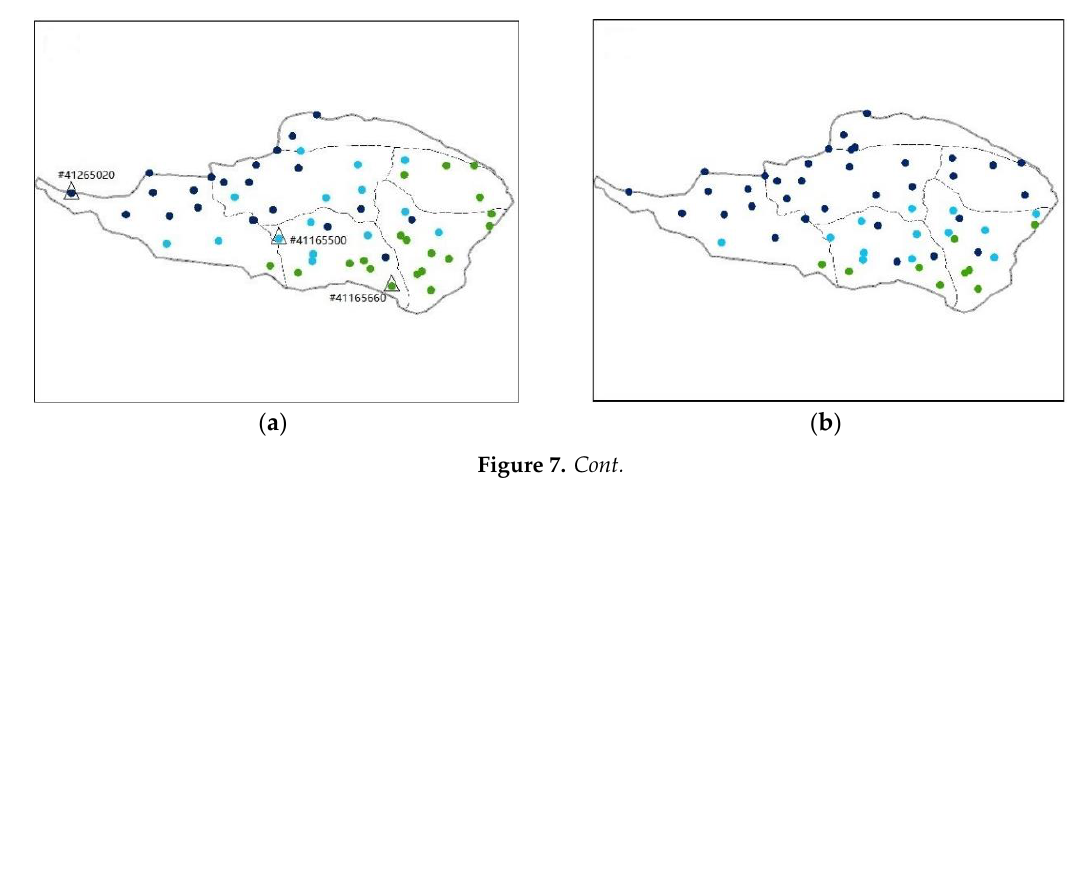
Figure 6. An average amplitude of change in groundwater level relative to 1980 for all alluvial monitoring wells (MWS) (1980 – 2017). Shading represents 95% confidence limits. Red dotted line represents a fitting line.